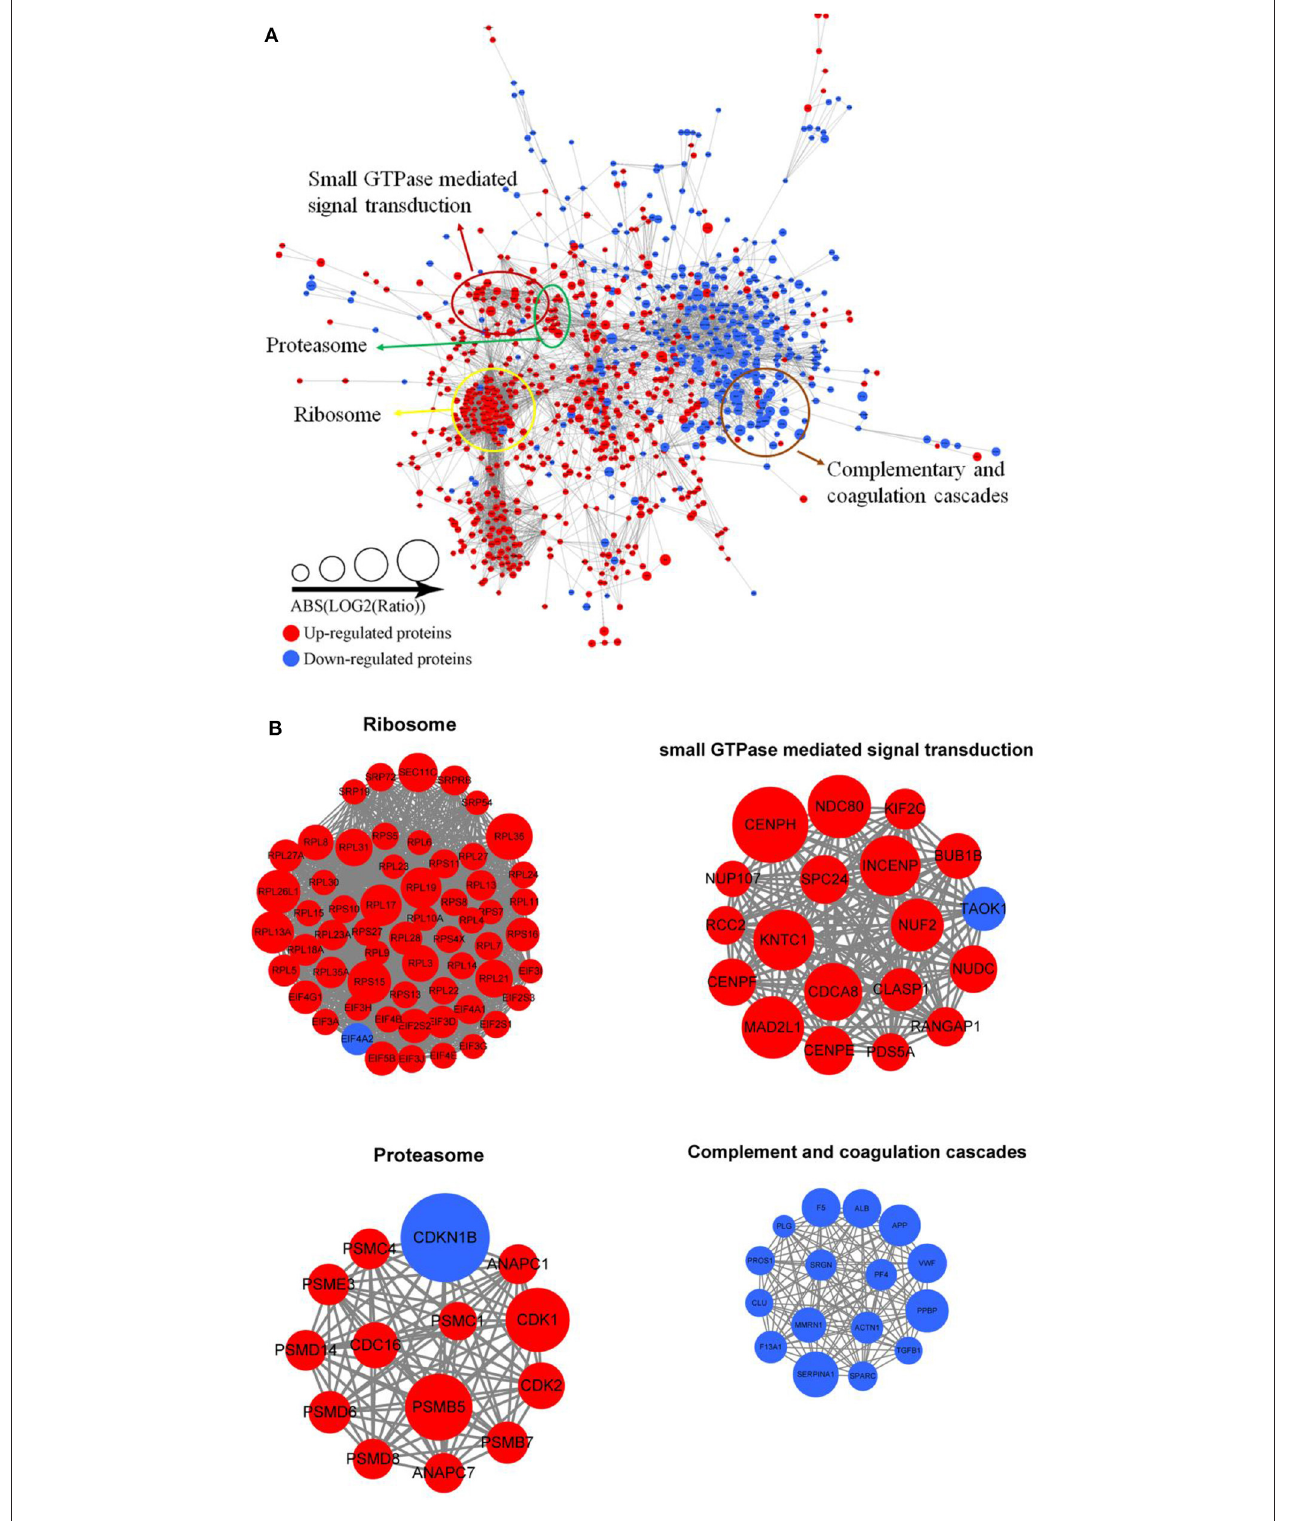
FIGURE 5 | Protein–protein interaction network analyses (A) for all differentially expressed proteins in iTfh cells compared to naive CD4 + T cells. Red represents upregulated proteins and blue represents downregulated proteins. Some highly interconnected clusters of proteins were indicated (B) , including ribosome, Small GTPase mediated signal transduction, proteasome, and complementary and coagulation cascades.